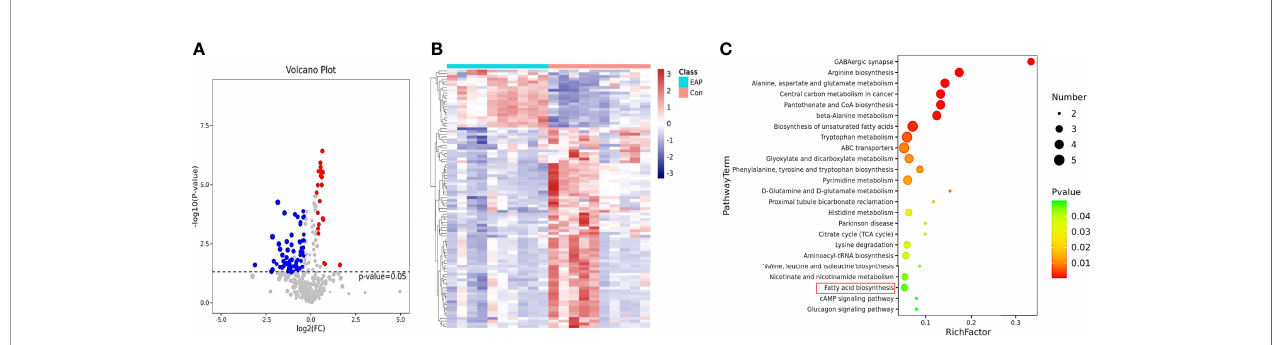
FIGURE 2 | Metabolomic pro fi les of control and EAP mice. (A) Volcano plot for metabolite analysis in feces from control and EAP mice. The red dots denote the signi fi cantly upregulated metabolites, the blue dots denote the signi fi cantly downregulated metabolites, and the gray dots denote the insigni fi cant metabolites. (B) A hierarchical clustering heatmap of metabolites in feces of control and EAP mice. Red represents increased expression, while green represents decreased expression. (C) A bubble chart of KEGG pathway enrichment. The disturbances in fatty acids are highlighted in red. n = 10/group; EAP, experimental autoimmune